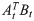
Schematics of the fractional counting method for publication and collaboration counts.Two matrices, the fractional publication counts by countries At and the topic distributions of papers Bt, were extracted from the document set of year t. (1) AtTBt represents the fractional publication counts by topics at year t. For further analysis, based on the hierarchical tree of clusters in Fig 2, the fractional publications by 41 topics are grouped into five topical clusters: material, plasma, device, diagnostics, and simulation. Rt is the aggregated matrix and is transposed in the figure to match with the hierarchical tree of 41 clusters. (2) The country profile of a paper is transformed into a collaboration matrix W1, which was distributed over the five topical clusters by weights. For each year, by aggregating the collaboration matrices of all published papers, we had five fractional collaboration matrices.